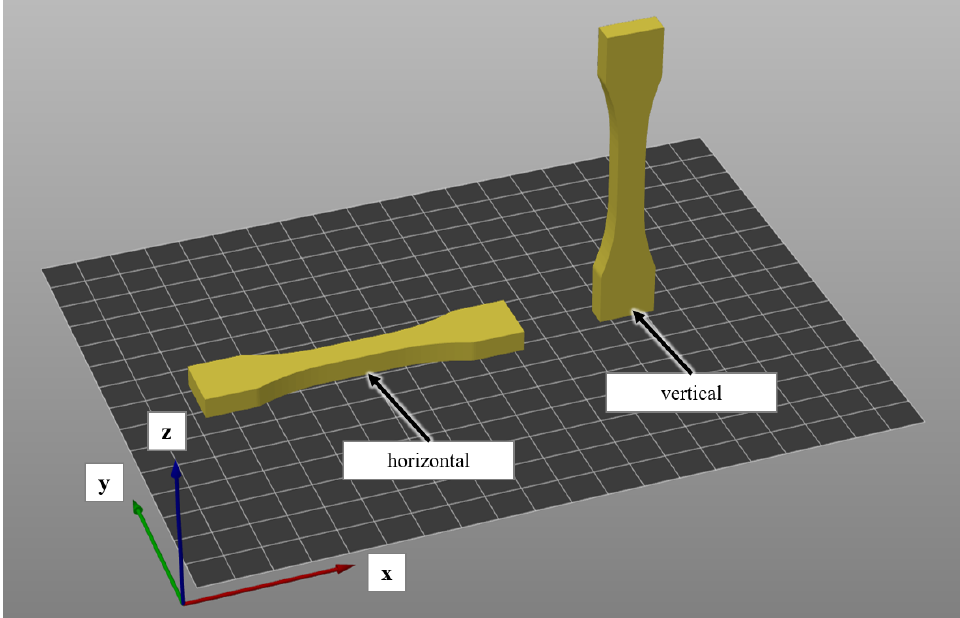
Figure 3. Horizontal manufacturing orientation ( left ) and vertical manufacturing orientation ( right